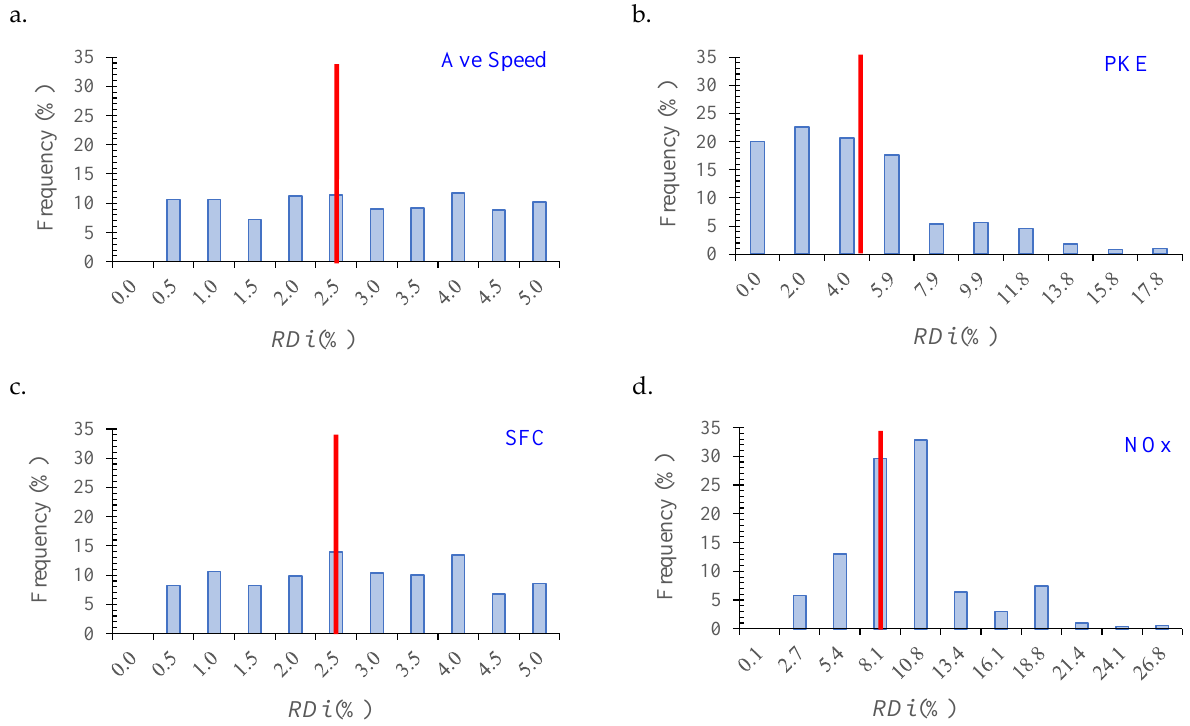
Figure 2. Frequency distribution of the RD i obtained for the 500 DCs for a duration of 20 min and Urban 1 region and the cases of ( a ) average speed, ( b ) positive kinetic energy, ( c ) specific fuel consumption, and ( d ) NOx emissions. Vertical red lines in these figures represent their respective MRD i .